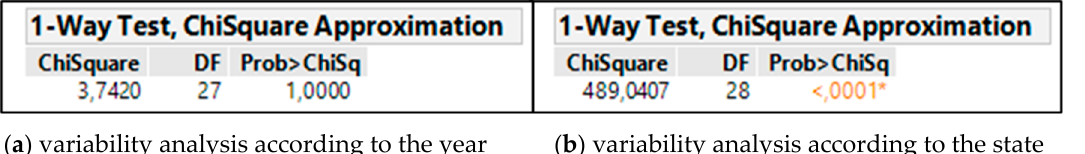
Figure 3. Results of Kruskal-Wallis test–variability of water use index influenced by time and the country.